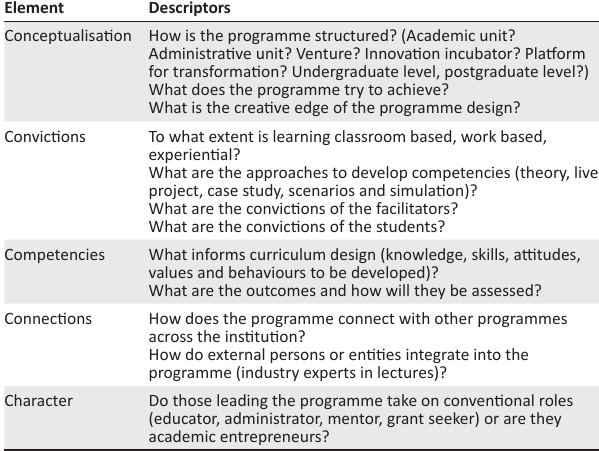
TABLE 1: 5C’s framework for entrepreneurship program design.